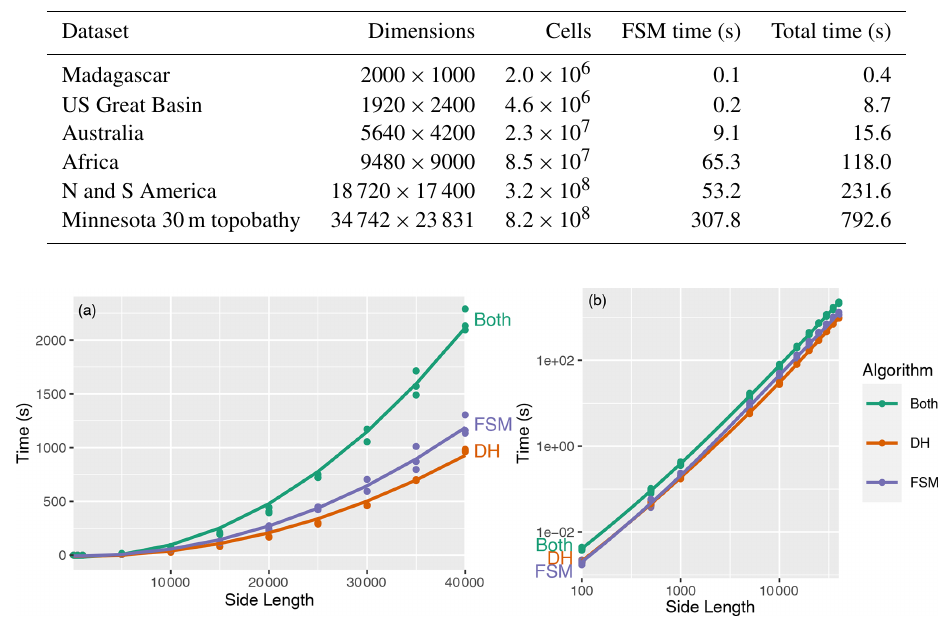
Figure 6. Performance on synthetic data. The left-hand plot shows the data on linear axes and the right-hand plot on log–log axes. The number of cells in each dataset is the square of the side length. The lines show N log N fits to each algorithm’s time ( R 2 ≈ 0 . 99 for each). “DH” shows the performance of the depression hierarchy algorithm, while “FSM” shows that of the Fill–Spill–Merge algorithm; “both” shows the addition of these two